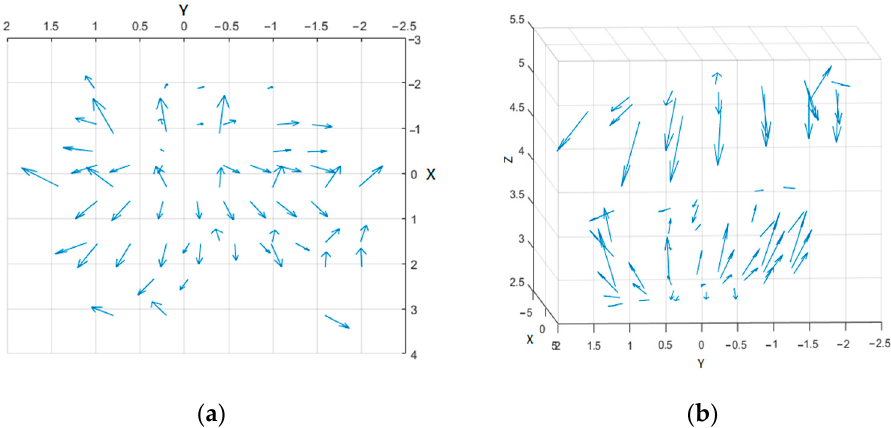
Figure 5. The error distribution and direction of observation points of the Kinect V2 RGB ‐ D camera. ( a ) Error distribution under the XOY plane; and ( b ) error distribution in 3D space. The direction of the arrow indicates the direction of the error, and the unit in the figure is mm.